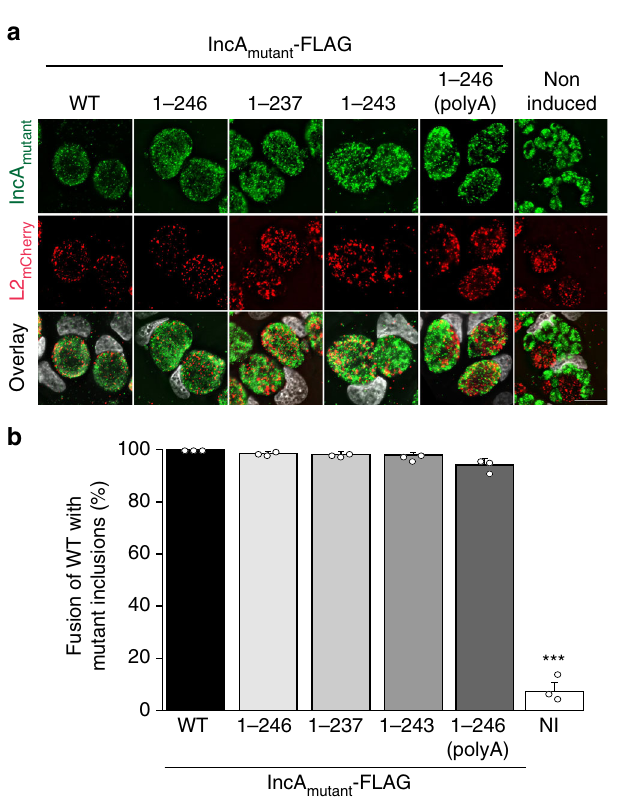
Fig. 5 Wild-type IncA rescues the activity of non-fusogenic IncA when expressed in trans . a HeLa cells were co-infected with the indicated IncA mutant -FLAG complemented IncA KO strains (IncA mutant, green) at a MOI of 5 and wild-type C. trachomatis expressing mCherry (L2 mCherry , red) at a MOI of 2. IncA mutant -FLAG expression was induced with anhydrotetracycline at 5 hpi. Not induced (DMSO) served as a negative IncA KO control. Cells were fi xed at 24 hpi and DNA was stained with Hoechst (gray). L2 mCherry (red) and IncA mutant (green) inclusions that have undergone fusion contain both red and green Chlamydia . Scale bar = 10 µ m. b Quanti fi cation of heterotypic fusion between L2 mCherry and IncA mutant inclusions. Data were normalized to IncA WT -FLAG. Graphs display the means of three independent experiments ± the standard deviation. Asterisks (***) denote a p -value < 0.001 (two-tailed student t -test). Source